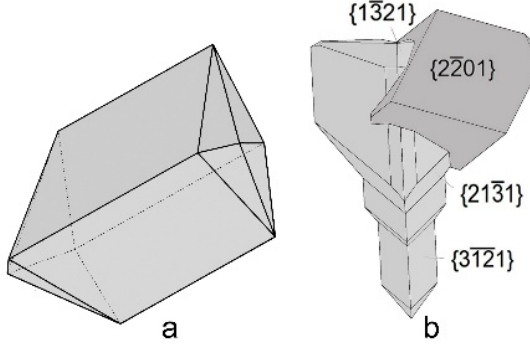
Figure 10. Morphology of calcite. ( a ) Distorted elongated calcite I twin. ( b ) Multiphase calcite I scepter twin with late rhombohedra.